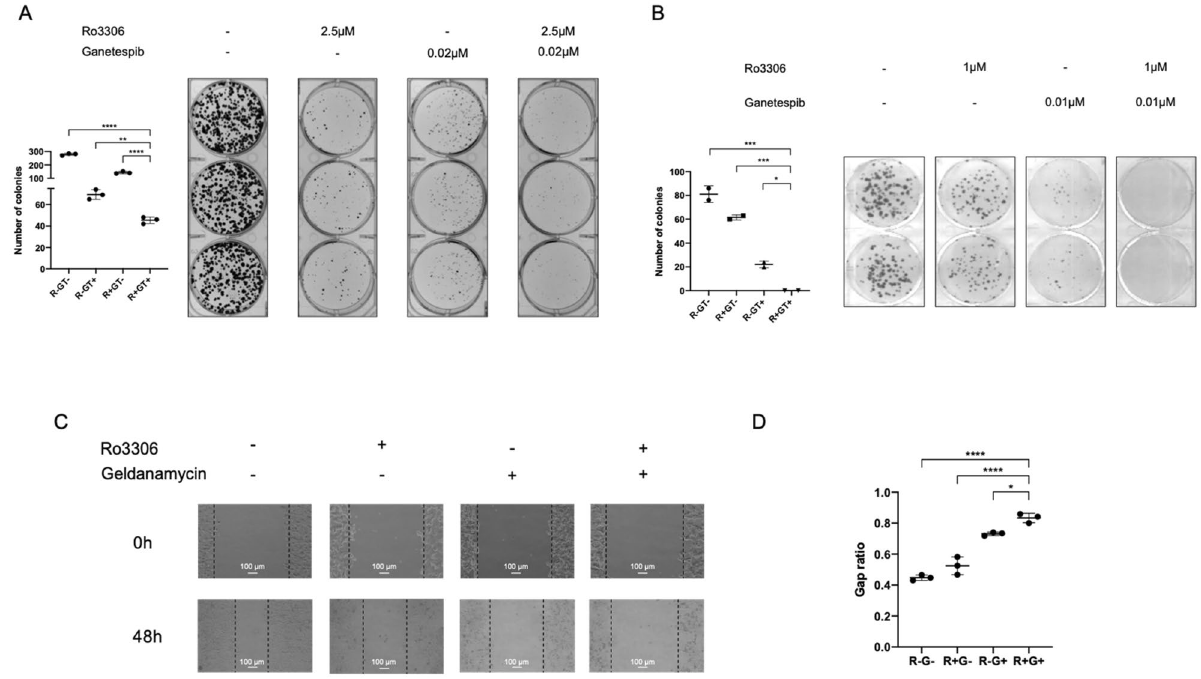
Figure 4. Combination CDK1 and HSP90 inhibitor treatment inhibits colony formation and migration in HCT116 cells. ( A ) In normoxia or ( B ) In hypoxia (0.5% O 2 ), HCT116 cells were treated with the indicated combination treatments for 72 h. Drug-containing media was replaced with regular culture media, and cells were allowed to grow and form colonies for 1 week. ( C ) Scratch assay and ( D ) Quantification for HCT116 cells under normoxia for 48 h. Gap ratio refers to the ratio of gap width at 48 h versus at 0 h. Cells were treated with Z-VAD caspase inhibitor to prevent cell death. (R: Ro-3306; G: geldanamycin.) n = 3. Statistical analysis was performed using one-way ANOVA supplemented with Dunnett test. Mean ± SD was shown. * p < 0.05, ** p < 0.01, *** p < 0.001, **** p <